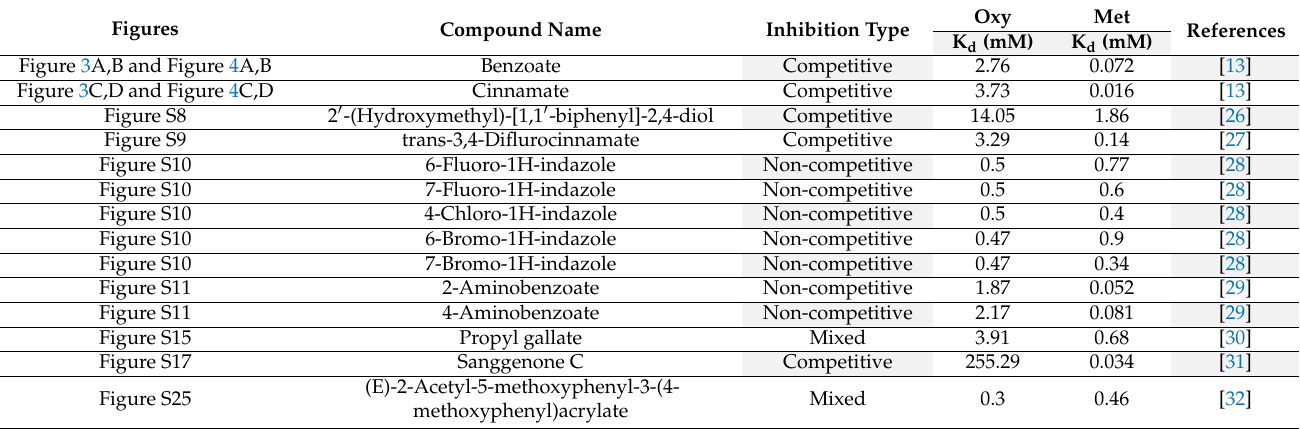
(E)-2-Acetyl-5-methoxyphenyl-3-(4- methoxyphenyl)acrylate